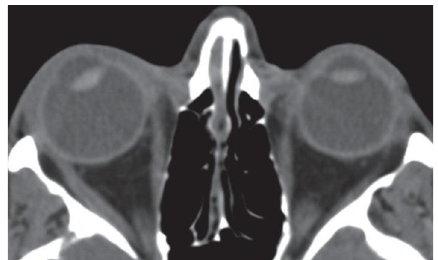
Figure 6: Open globe injury in a 24-year-old man. Axial unen- hanced CT image showing anterior chamber deepening and dis- located lens in the right